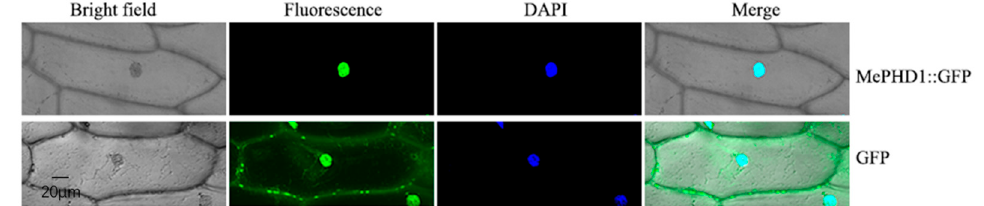
Figure 4. Nuclear localization of MePHD1. Top row/bottom row: the corresponding bright field, fluorescence, merged fluorescence image, and DAPI image of MePHD1-GFP/GFP control. Bar = 20 μ m.